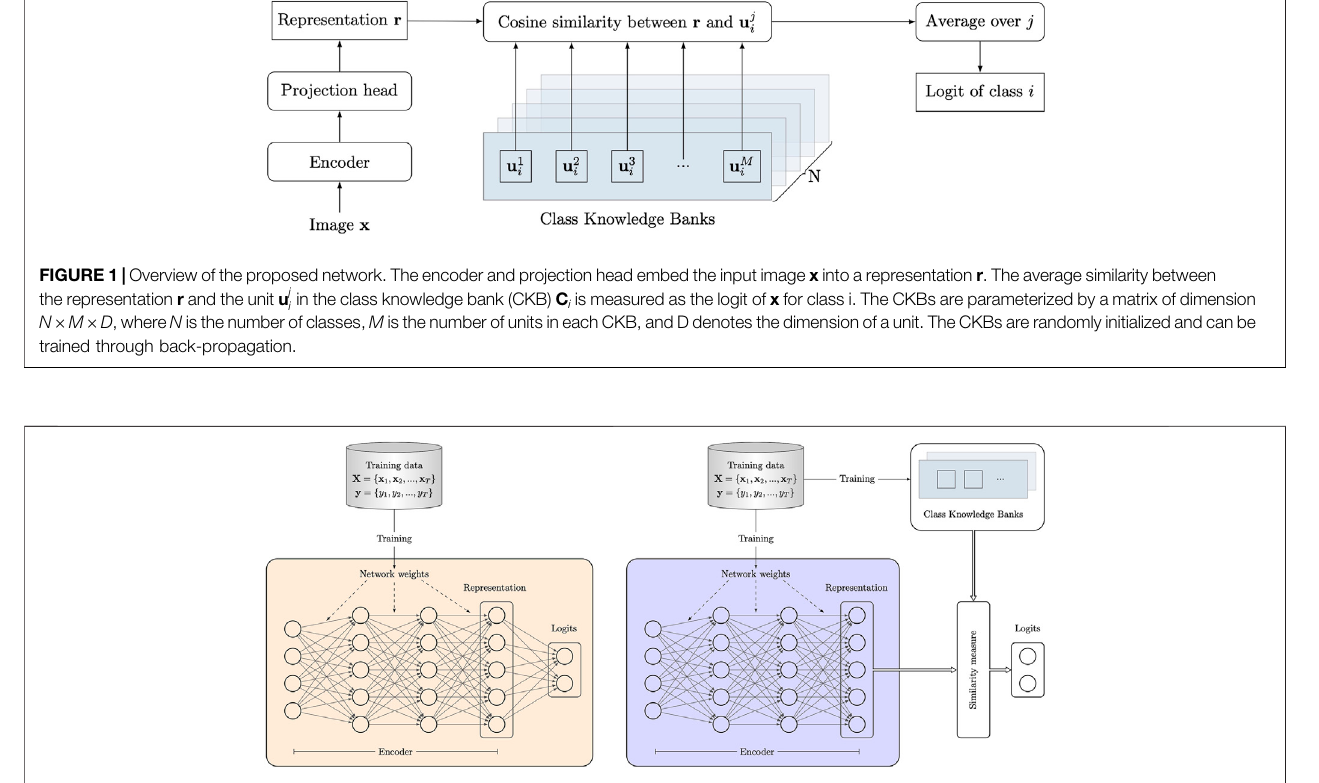
FIGURE 2 | Comparison between common classi fi cation networks and the network with the proposed class knowledge banks. A common image classi fi cation network on the left is trained on the training data. After training, class knowledge in the training data only functions through the network weights. By contrast, except for the network weights, the proposed class knowledge banks can learn class knowledge from the training data and store the knowledge. The learned knowledge in the CKBs participates in the classi fi cation process by measuring the similarity between the CKBs and the representation of the